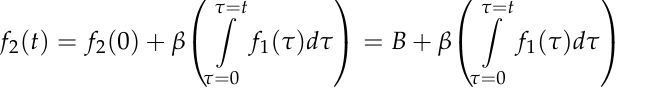
Fitting curve ( D = -11.477 D y 2 )